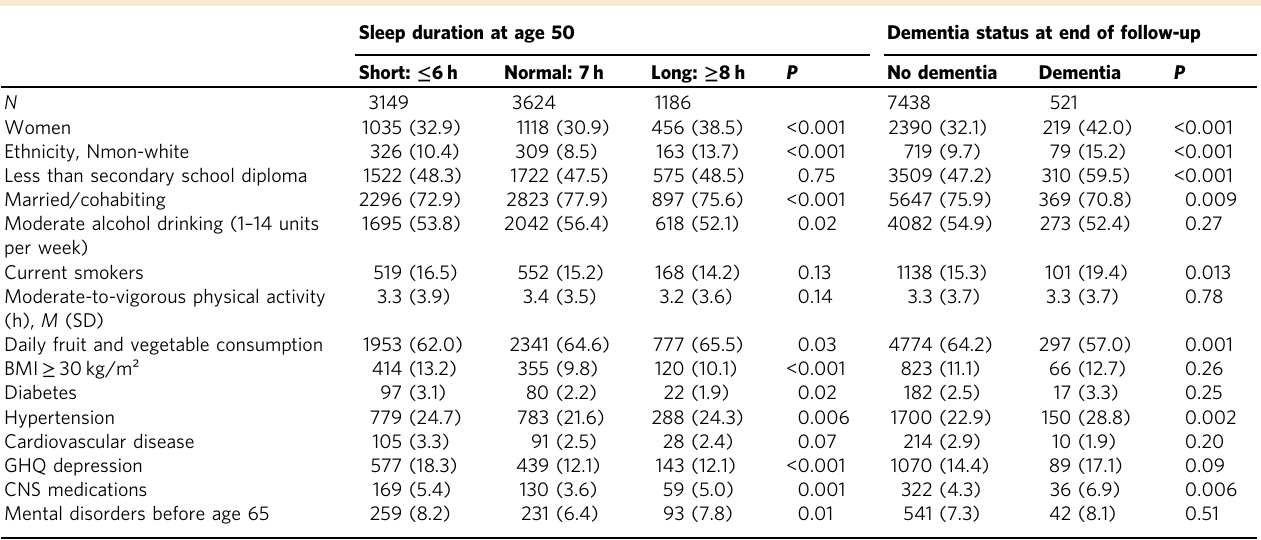
Fig. 1 Flow chart for population selection. This fi gure represents the sample selection for the analysis of sleep duration at age 50, 60, and 70, as well as for the analysis of sleep trajectories. Table 1 Characteristics of the study population at age